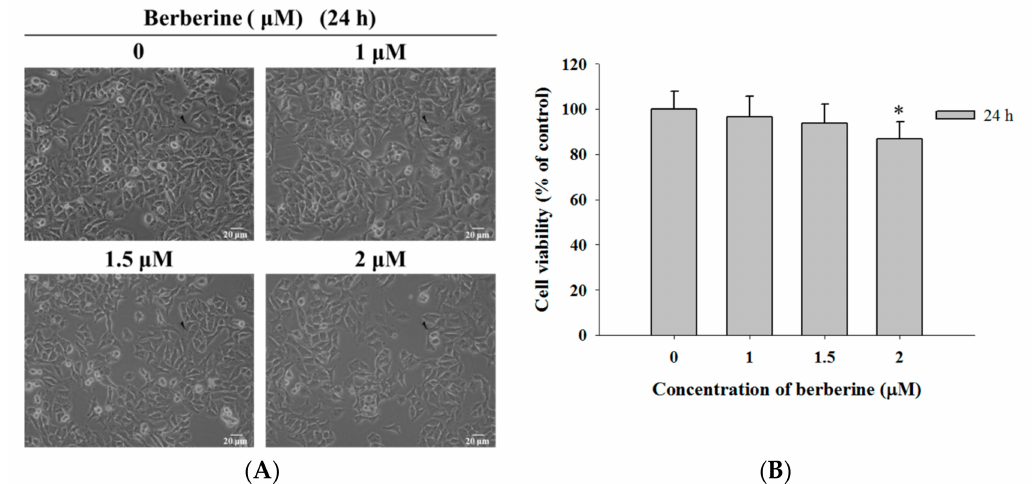
Figure 1. The berberine induced cell morphological changes and decreased the cell viability of A375.S2 cells. The cells (1 × 10 5 cells/well) were incubated with berberine at different concentrations (0, 1, 1.5, and 2 µ M) for 24 h. The cells were examined and photographed for morphological changes ( A ) or they were collected for the total percentage of the total viable cells ( B ) as described in Materials and Methods. * p < 0.05, significant difference between berberine-treated groups and the control as analyzed by one-way ANOVA analysis of